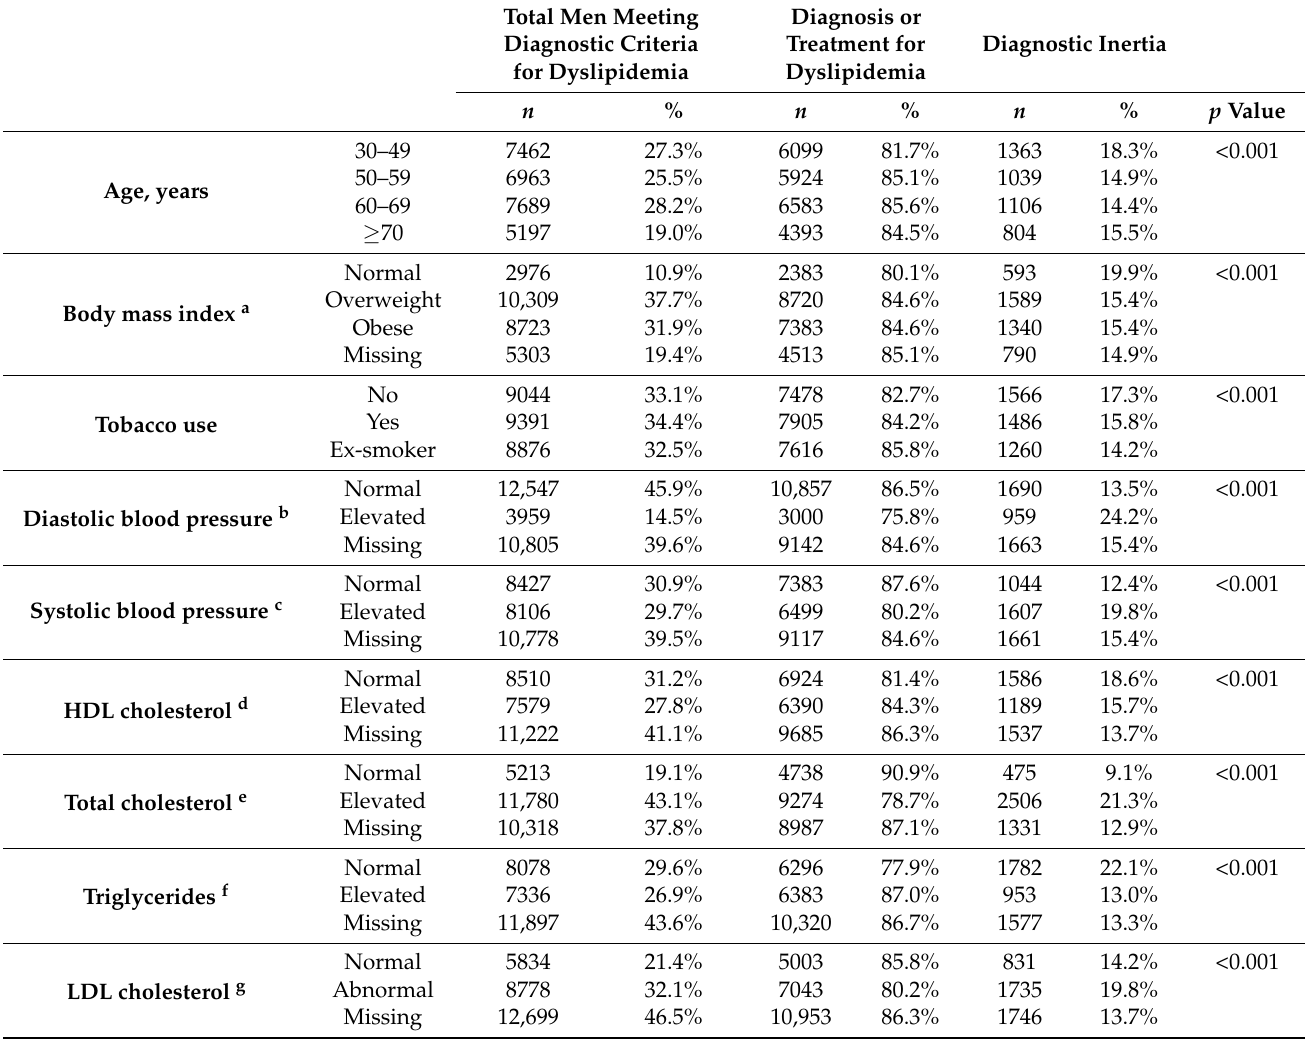
Table 1. Prevalence of diagnostic inertia in men, according to physical and analytical variables.